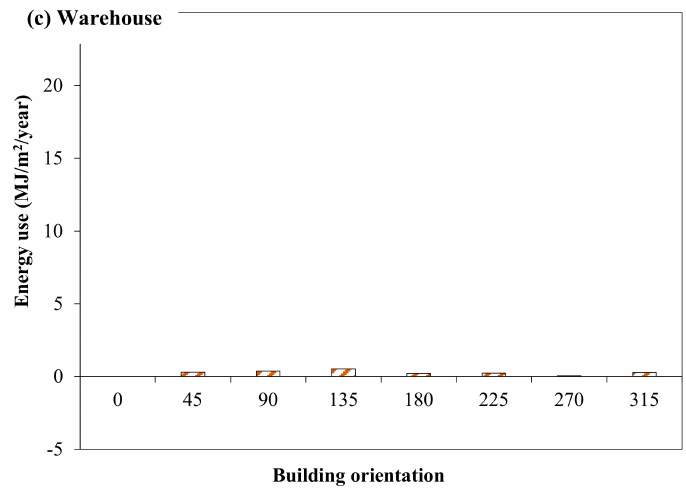
Figure 19. Effect of building orientation in energy use. ( a ) House; ( b ) Office; ( c ) Warehouse.